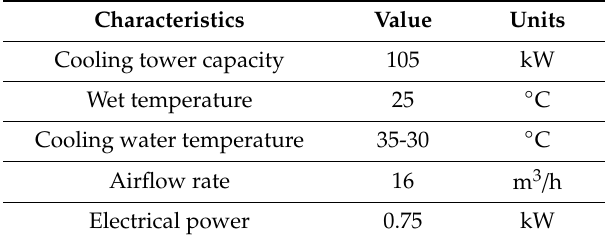
Table 2. Technical characteristics of the FXT-26 cooling tower [32].